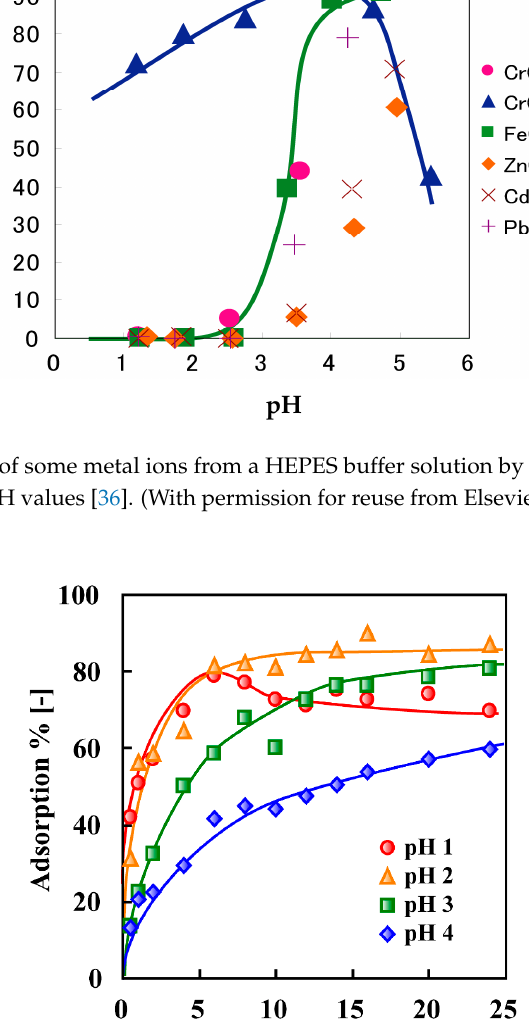
Figure 37. Temporal change in the Cr(VI), Cr(III), and total Cr concentrations at pH = 1 under the same conditions as shown for Figure 36 [35]. (With permission for reuse from Elsevier B.V.).